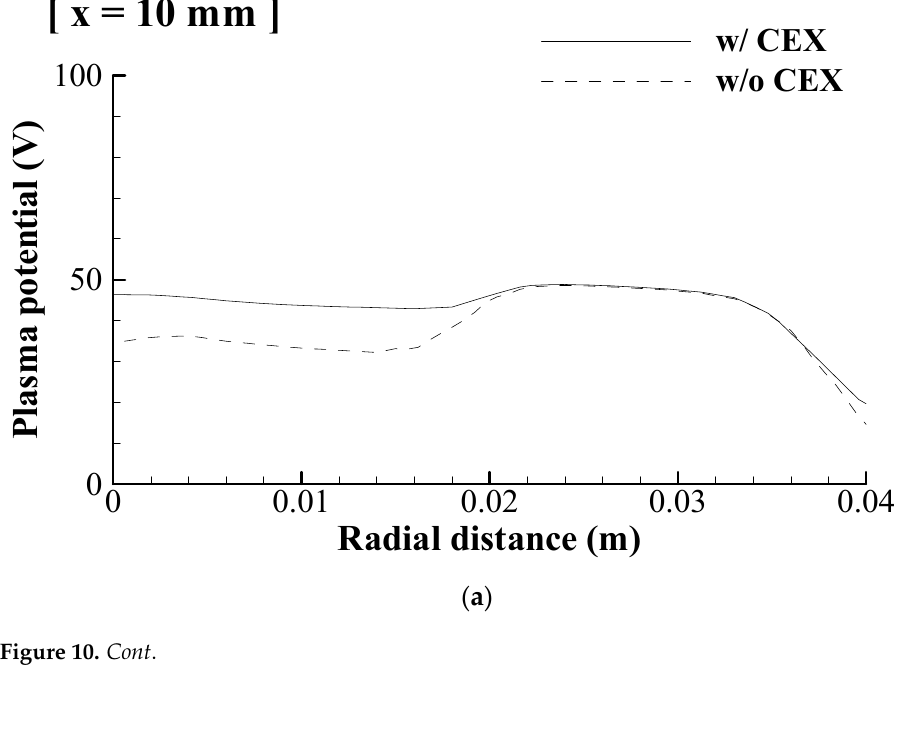
Figure 9. Contours of the plasma potential (top) and Xe + ion number density (bottom) for Case 1 without CEX effects.